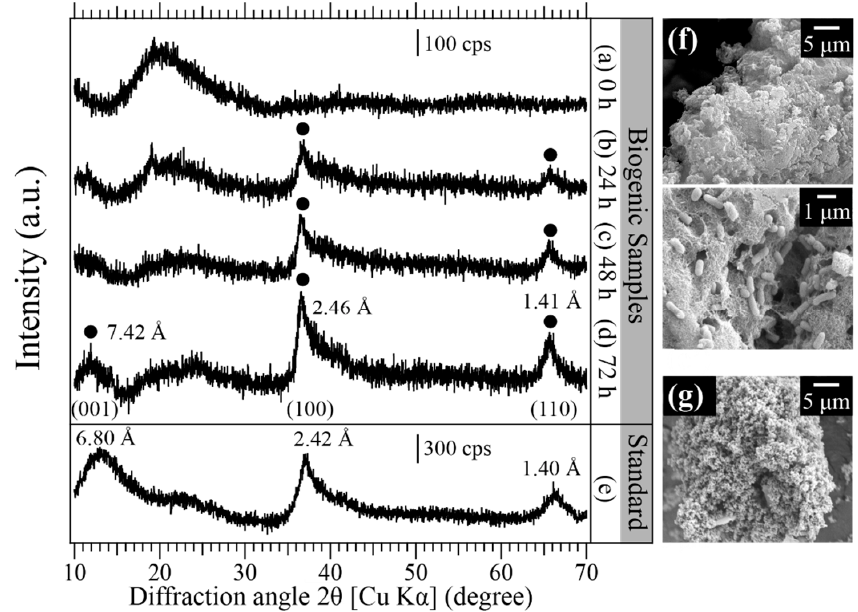
Figure 8. XRD diffraction patterns of Mn-precipitates recovered during Mn(II) oxidation by isolate SK3 at 0 h ( a ), 24 h ( b ), 48 h ( c ), and 72 h ( d ), in comparison with chemically synthesized acid birnessite ( e ). ● , birnessite (JCDD 43-1456). Sampling times of the Mn-precipitates correspond to those shown in Figure 5a ( ■ , +Cu(II)). SEM images of sample ( d ) and ( e ) are shown in ( f ) and ( g ), respectively.